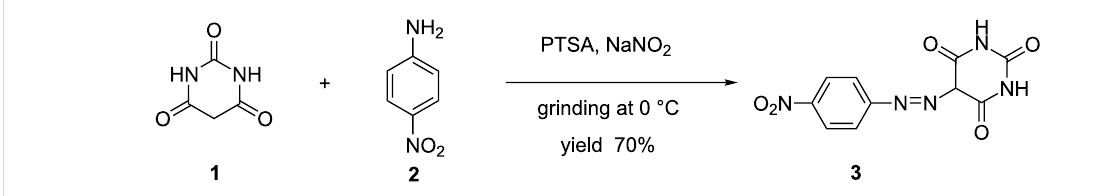
Scheme 1: PTSA-catalyzed diazotization and azo coupling reaction.